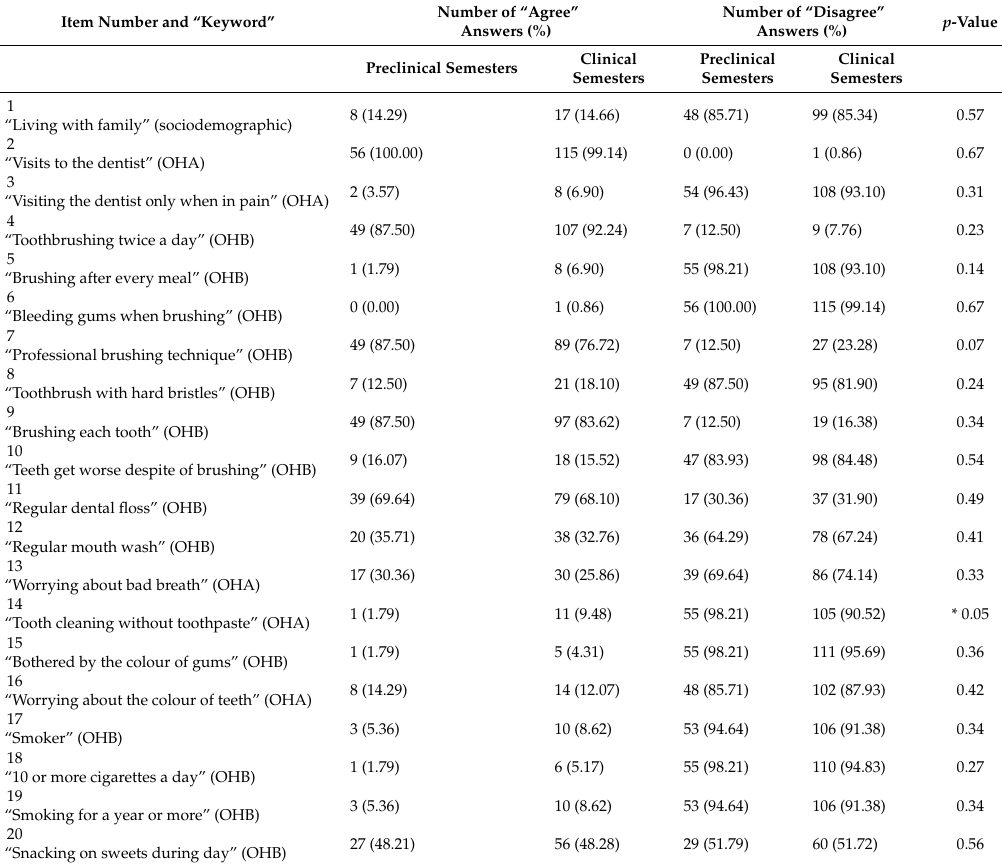
Table 4. Percentages and analysis of “Agree” and “Disagree” responses to items of oral health attitudes (OHA) and oral health behaviour (OHB) comparing the preclinical and clinical semesters’ dental students. Item Number and “Keyword” Number of “Agree” Answers (%) Number of “Disagree” Answers (%) p